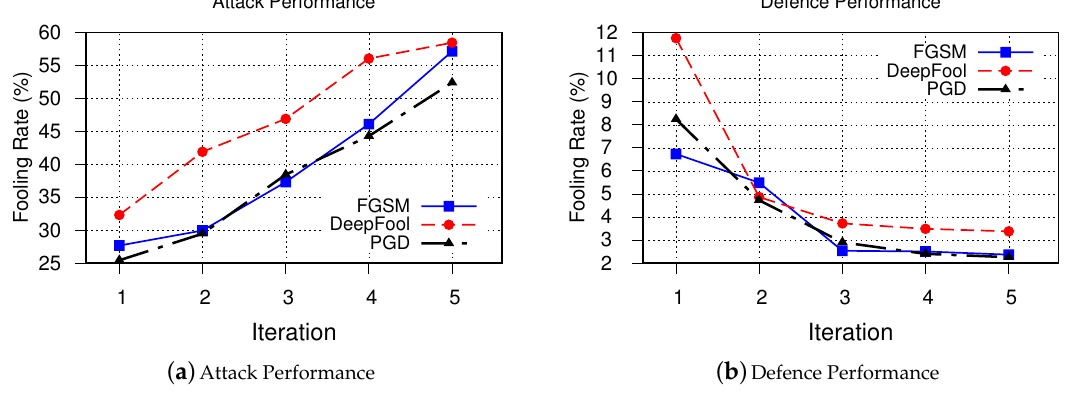
Figure 9. Overall simulation results for all three attack types. We observed similar trends for all three attack methods in both attack and defence